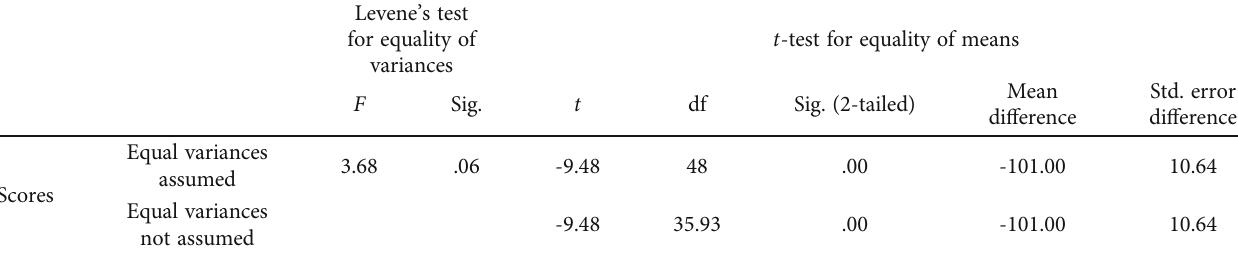
Table 9: Inferential statistics of the motivation posttests.